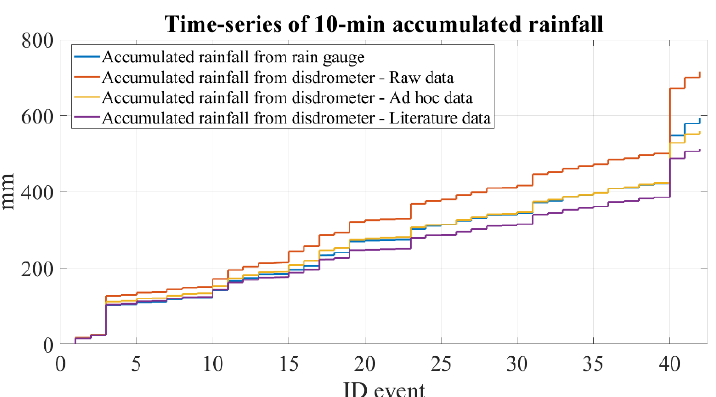
Figure 4. Comparison, over the entire analyzed period, of 10-min cumulative precipitation sums (mm) between raw (red line), ad hoc (yellow line) and literature (magenta line) disdrometric data and the FAK010A rain gauge (blue line).